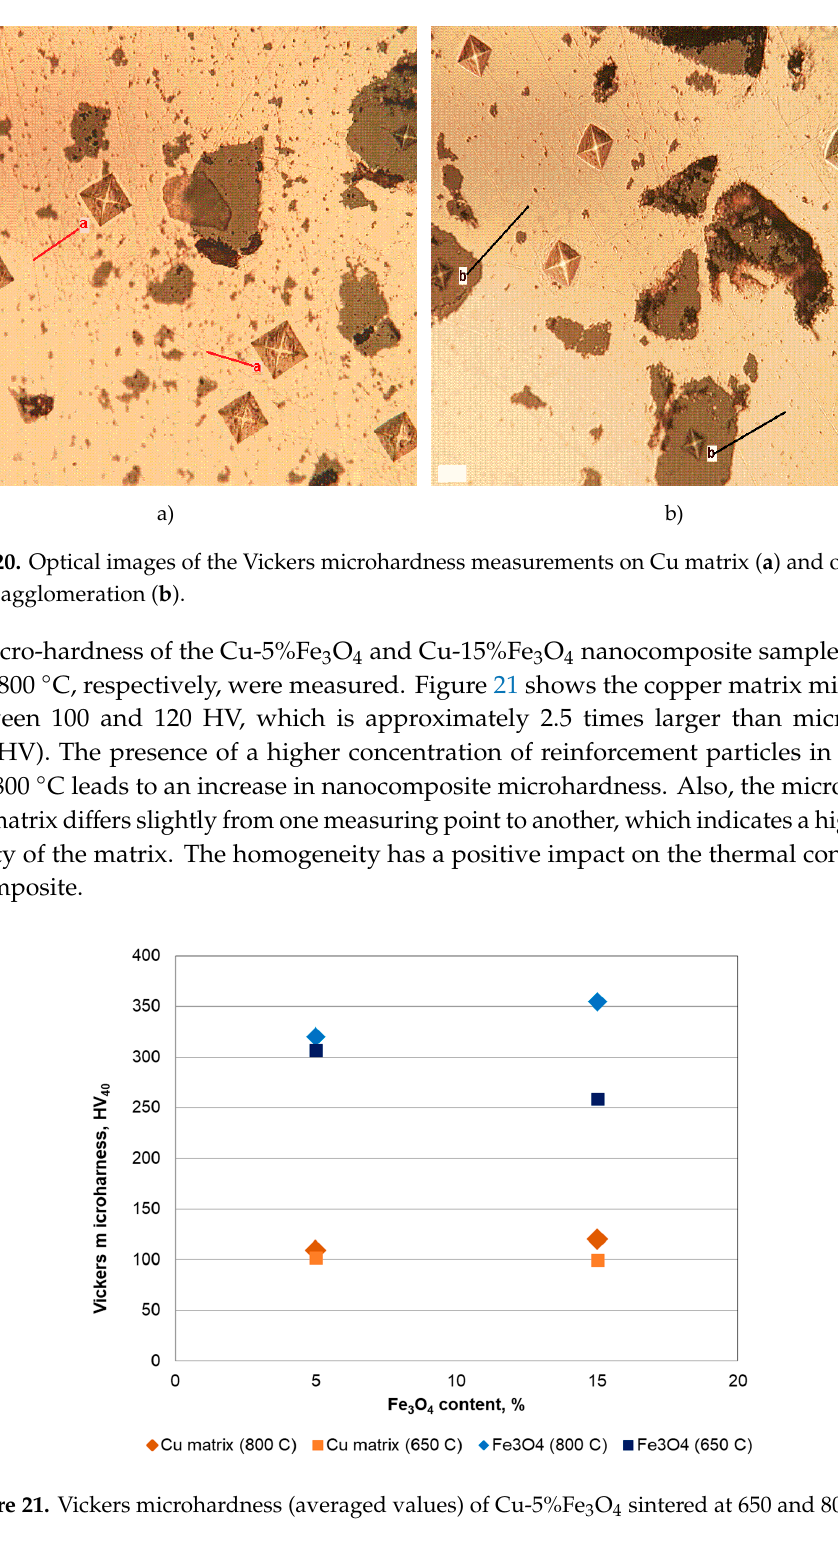
Figure 21. Vickers microhardness (averaged values) of Cu-5%Fe 3 O 4 sintered at 650 and 800 °C.